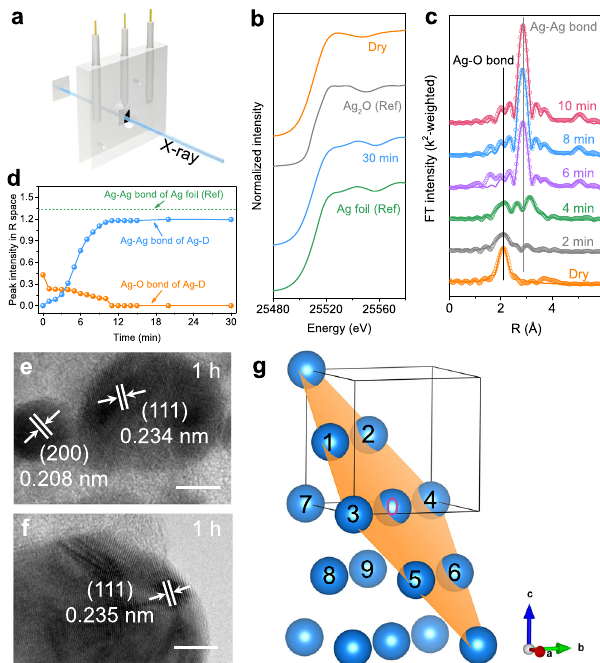
Fig. 2 Fast operando XAS experiments. a Schematic illustration of the reactor for operando XAS. b Normalized XANES pro fi les. c Time-resolved k 2 -weighted FT EXAFS spectra (circles) and the fi tting result (lines) for the Ag-D catalyst. d Time-resolved peak intensity of the Ag – Ag bond and Ag – O bond for the Ag-D catalyst. e , f HRTEM images at different positions of the Ag-D catalyst after a one-hour reaction. g Schematic illustration of the local environments of Ag atoms in the (111) plane. Scale bar in e and f is 5